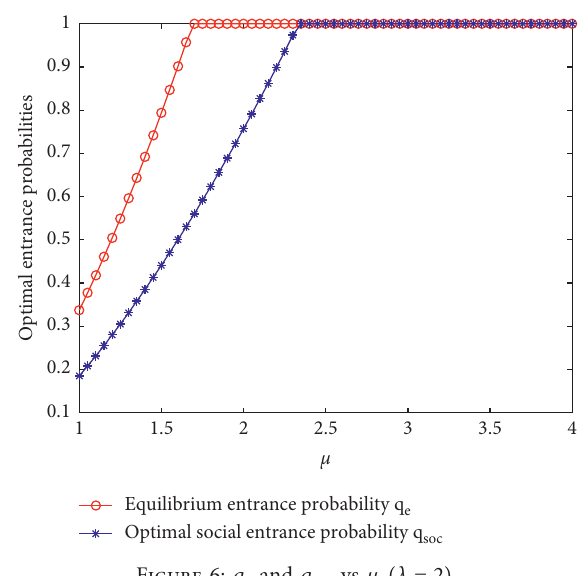
q vs λ ( μ � 2 ) . e and soc